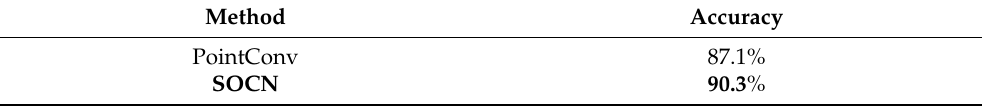
Table 1. Accuracy performance in stacked objects classification.